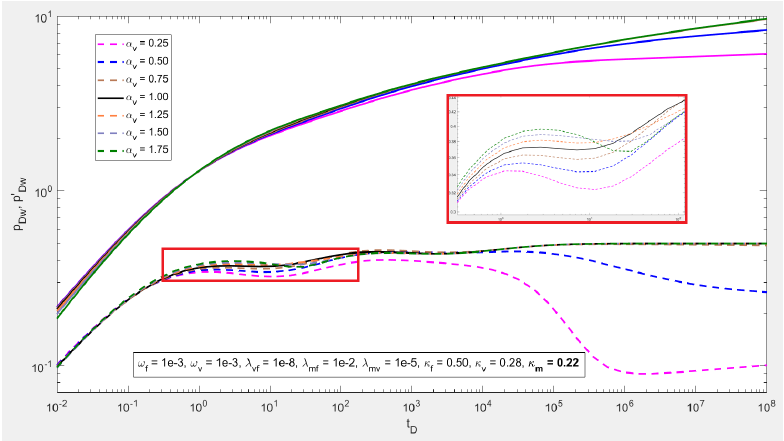
Figure 4. Effects of considering anomalous flow only in the vugular system, α f = 1, α m =